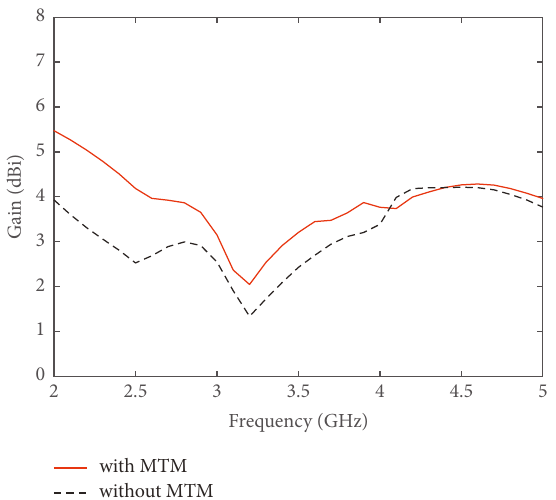
Figure 13: Peak gain of the proposed PLPA antenna with and without MTM.